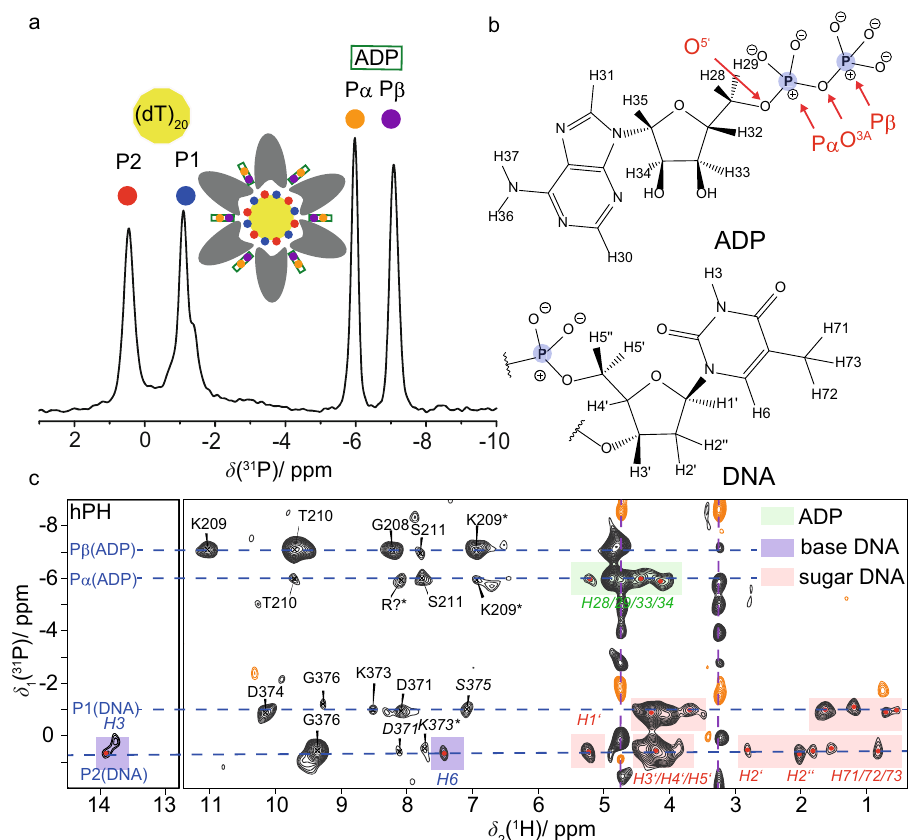
Fig. 3 ADP and DNA recognition in DnaB highlighted by phosphorus-proton contacts identi fi ed at fast MAS. a 1 H → 31 P (hP) CP-MAS spectrum of DnaB:ADP:AlF 4 − :DNA adapted from ref. 57 (http://creativecommons.org/licenses/by/4.0/) showing the resonance assignments of the DNA and ADP phosphate groups. The shoulder in the 31 P resonance at ~ − 1.4 ppm possibly results from rigidi fi ed DNA nucleotides, which are, however, not coordinating to DnaB. b Chemical structures of ADP and DNA (thymidine) molecules including the numbering of proton atoms following the convention of the BMRB database (DNA) and the recent IUPAC recommendations for nucleoside phosphates 107 . Phosphorus atoms are highlighted in blue. c CP-based hPH correlation spectrum (CP contact time 3 ms) recorded on DnaB in complex with ADP:AlF 4 − and DNA at 20.0 T external magnetic fi eld and 105 kHz MAS. The protein resonance assignment is taken from ref. 44 (BMRB accession code 27879). Regular-printed residue labels: Chemical-shift deviation to reported proton shifts <0.05 ppm. Italic-printed residue labels: Chemical-shift deviation to assigned proton shifts ≥ 0.05 ppm. All proton shifts are assigned to amide backbones, except the ones indicated by an asterisk, which are associated to sidechain atoms. Correlations between the phosphate groups and ADP or DNA are highlighted in green and light red/purple, respectively. The assignments of the DNA proton resonances are based on average chemical-shift values reported in the BMRB database (www.bmrb.wisc.edu). The pink dashed lines highlight signals from insuf fi ciently suppressed DNA in